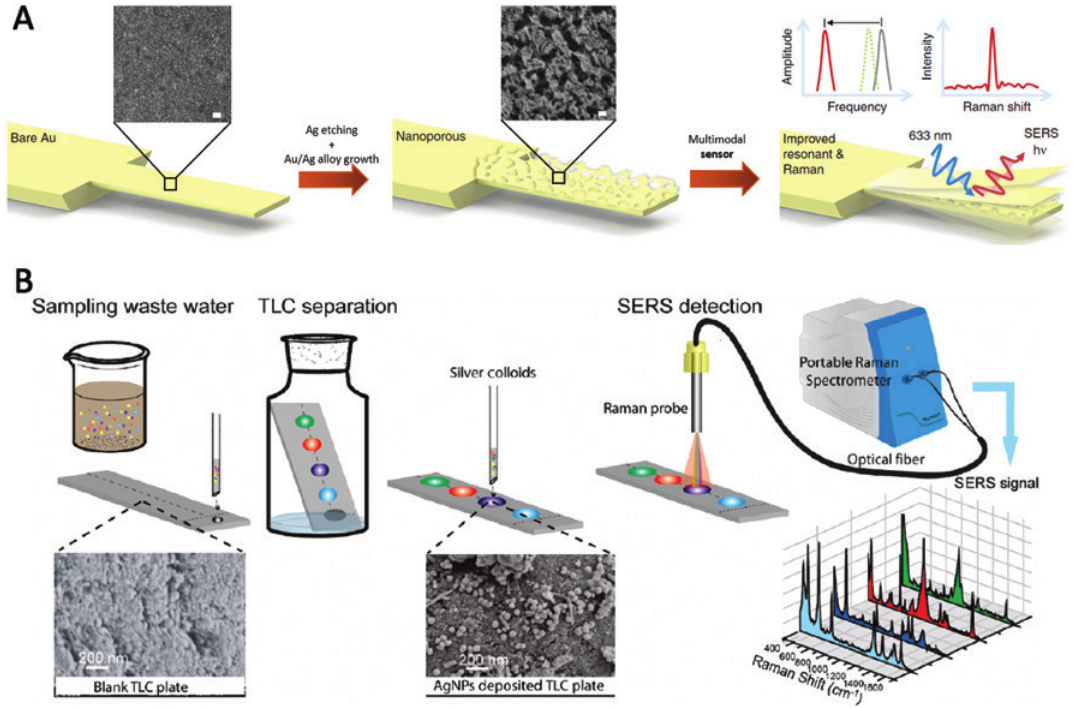
Figure 4: Combined techniques for small-molecule detection. (A) Combination of SERS detection on a micro-resonator. The two images represent the resonator surface before and after the chemical treat- ments performed to produce a layer of porous gold. Adapted by permission from Macmillan Publishers Ltd.: Nat Commun 5: 3456, copyright 2014 [48]. (B) Schematic illustration of TLC-SERS for on-site detection of aromatic pollutants in wastewater. The two images show the SEM characterization of the blank TLC plate and the silver NPs deposited on the TLC plate, respectively. Reprinted with permission from Environ Sci Technol, 2011, 45 (9), pp 4046–4052. Copyright 2011 American Chemical Society